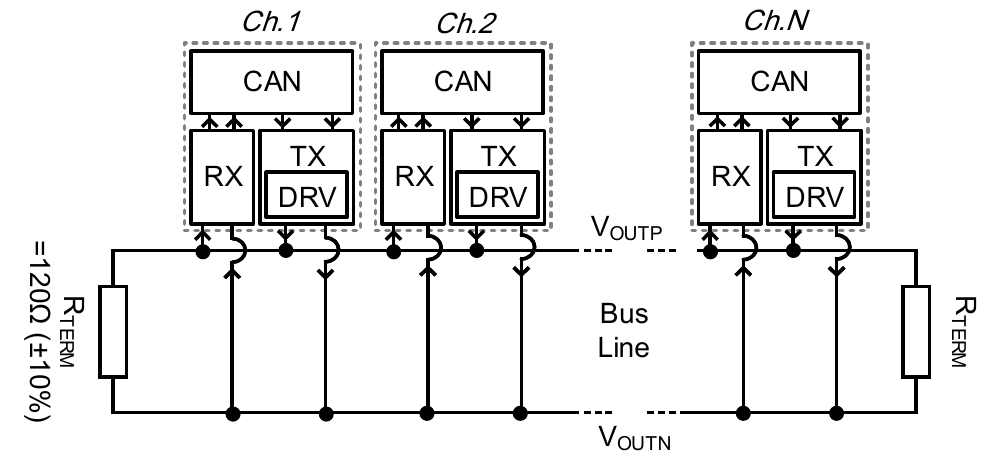
Figure 2. Block diagram of controller area network (CAN).